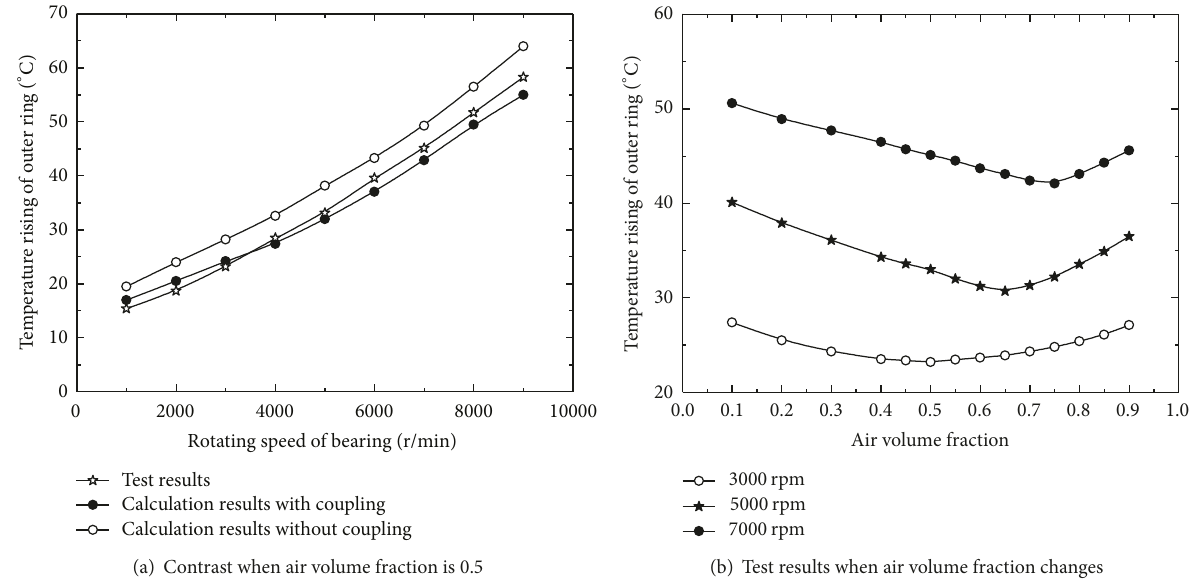
Figure 13: Contrast between experimental and calculation